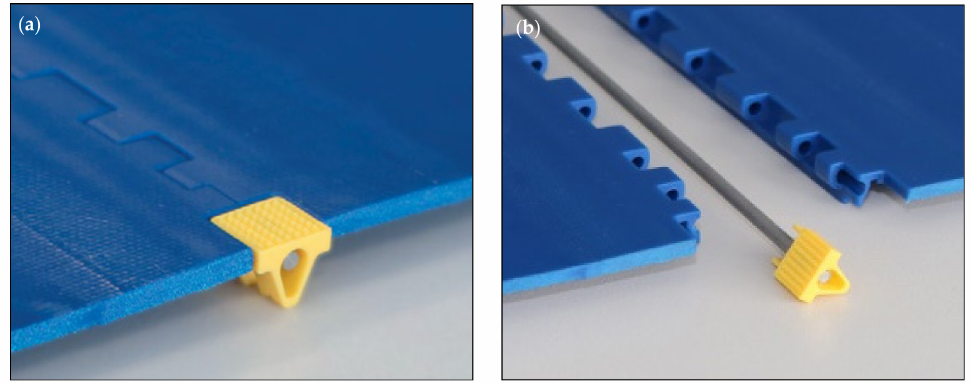
Figure 7. SaniClip: ( a ) general view, ( b ) hinge pin connected to a yellow stick